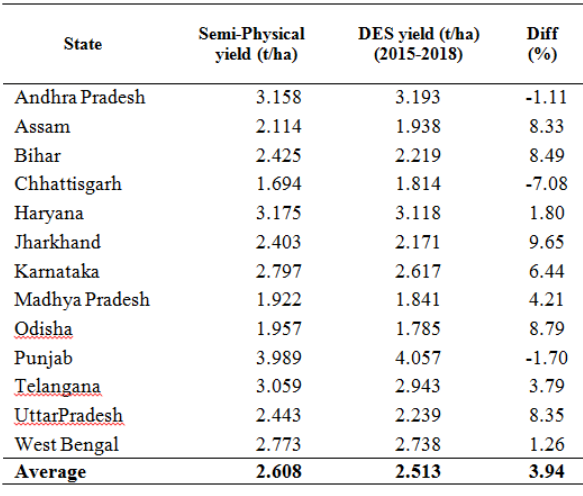
Figure 9: Kharif Rice Yield Map of Year 2018-19 Figure 6: Temperature Stress map of India during 13-20 Aug, 2018 (1: No stress; 0: Maximum stress) The state level comparison with the reported DES yield indicated an average underestimation of 3.94 %. In each state the estimation remained the range of ± 10% with compare to reported DES yield of last three year 2015-18 (Table 2 and Figure 10). The absolute difference between reported and semi- physical grain yield was found to be least in AP (1.11 %) and highest in Jharkhand (9.65 %). The RMSE between reported DES and calculated Semi-physical method grain yield in different states was found to be 0.15 t/ha and R 2 of the thirteen kharif rice growing states resulted in a R 2 of 0.97 (Figure 10).